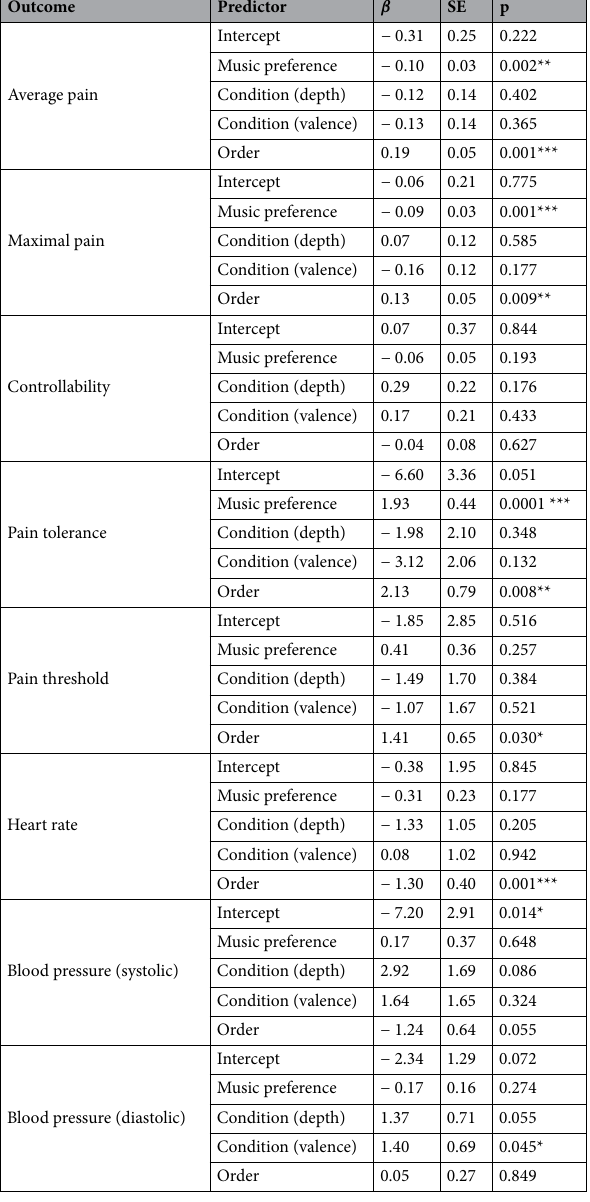
Table 2. Linear mixed effects regression analyses. Music preference, music condition, and experimental order as predictors of five pain outcomes. Beta regression coefficient; SE standard error. Intercept values are for